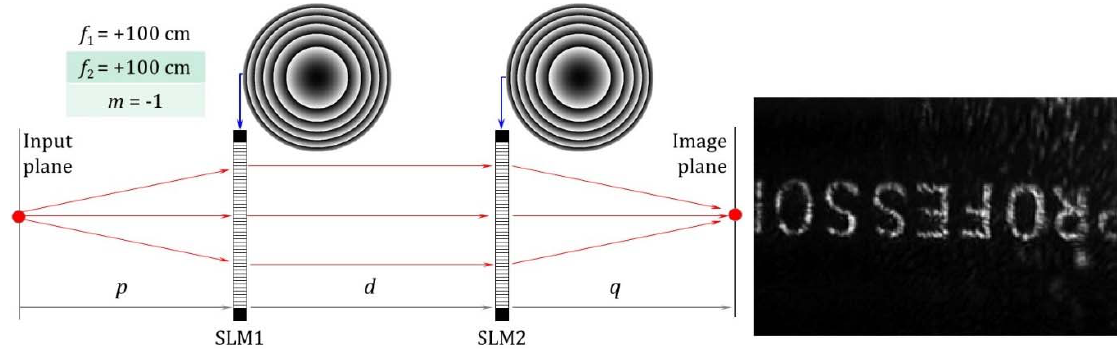
Figure 6. Zoom system configuration with f 1 = +100 cm and f 2 = +100 cm and experimental image with magnification of m = − 1.